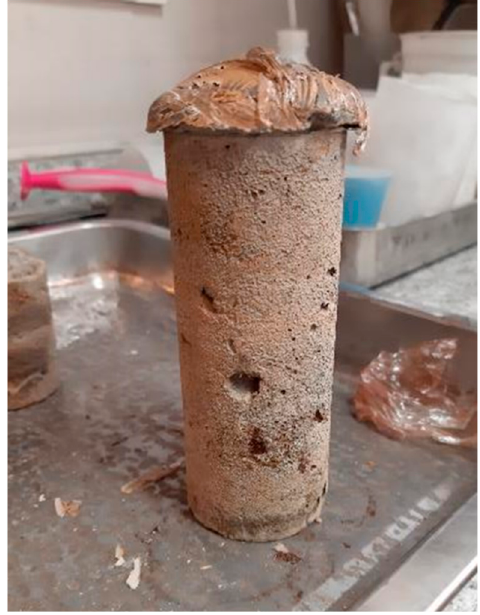
Figure 16. Consistency of Method VI with water/solids ratio of 20%, 7 days at 90 °C.